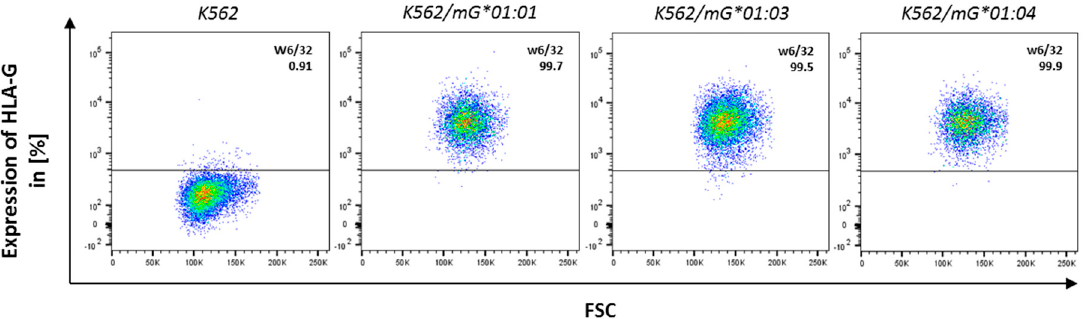
Figure A7. FACS analysis of HLA-G expression. Transduction efficiency of HLA-G*01:0x was verified by FACS analysis. Untransduced K562 cells were used as negative control.